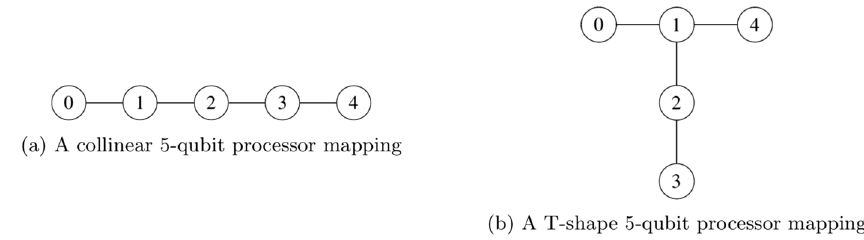
Figure 6. The two possible 5-qubit processor mappings on the architectures shown in Fig.